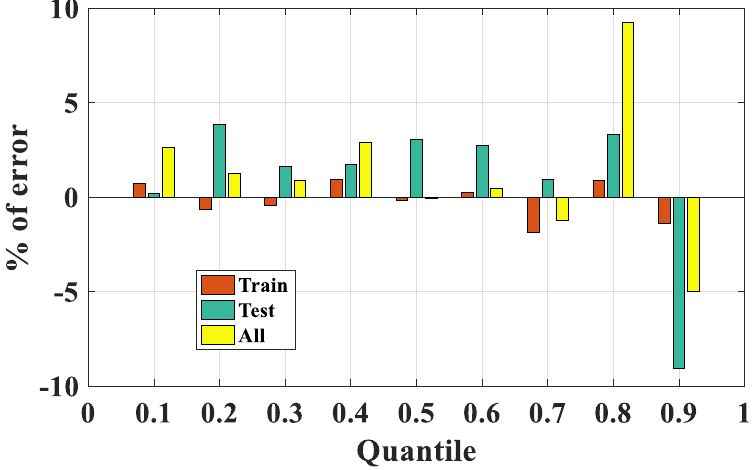
for ( a ) training data, ( b ) testing data, and ( c ) all data.